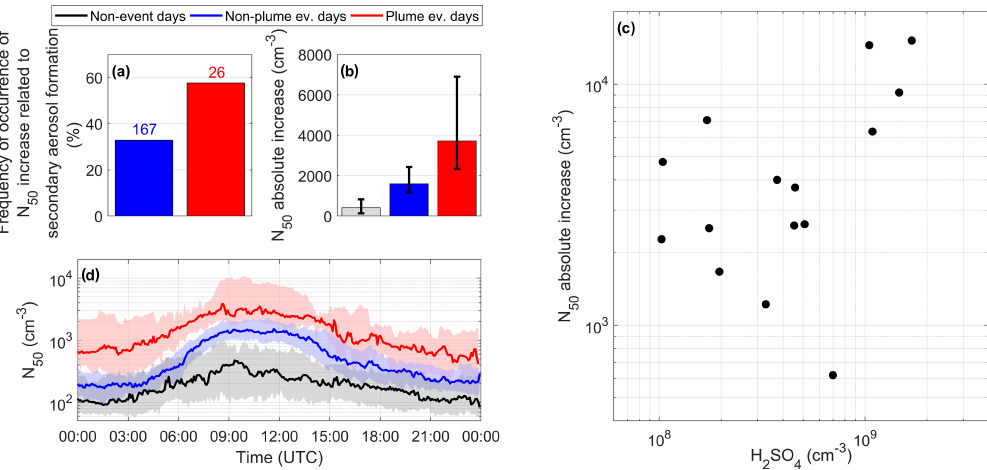
Figure 9. Increase in potential > 50nm CCN particle concentration ( N 50 ) during NPF under in-plume and off-plume conditions. (a) Fre- quency of occurrence and (b) magnitude of the absolute increase. See Fig. 3 for an explanation of symbols. In (a) , numbers on the plot indicate, for non-plume and plume conditions, the total number of NPF events included in the statistics. (c) Link between the increase in N 50 and [H 2 SO 4 ] on plume days. (d) Median diurnal variation of N 50 in the different conditions, including non-plume non-event days. Lower and upper limits of the shaded areas indicate the 25th and 75th percentiles of the data,